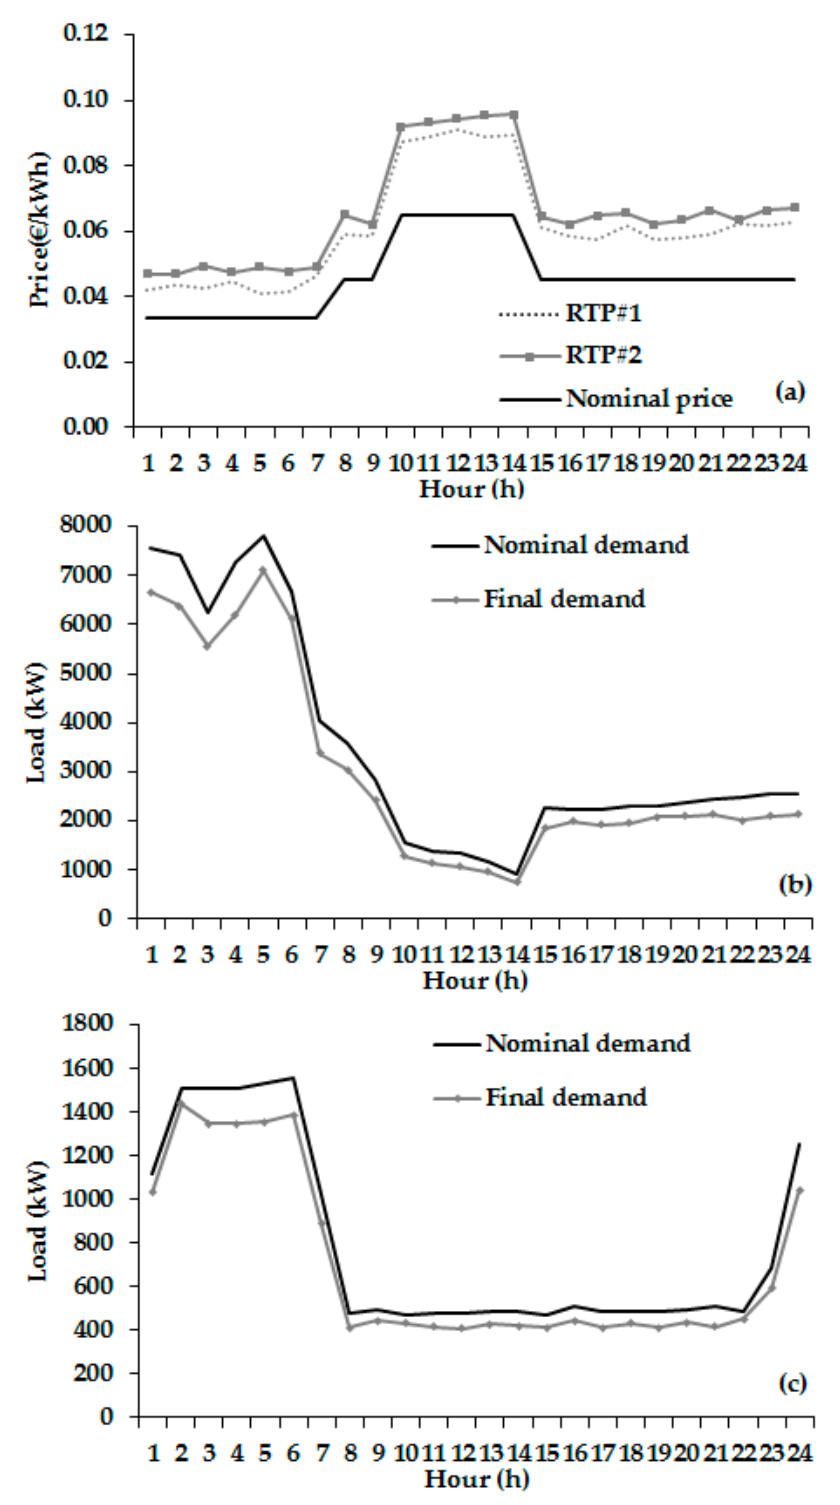
Figure 14. SC objective results with logarithmic DR model: ( a ) Nominal price and RTP; ( b ) nominal and final demand of consumer 1 and ( c ) nominal and final demand of consumer 2.